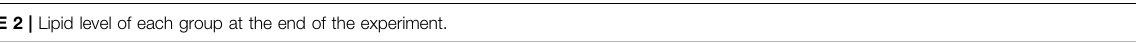
TABLE 2 | Lipid level of each group at the end of the experiment. Group